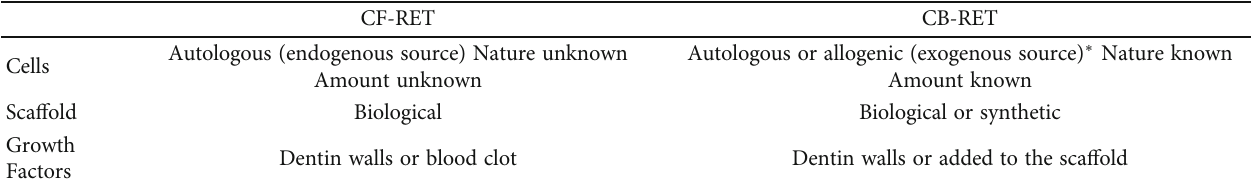
Table 1: Comparison between cell-free regenerative endodontic therapy (CF-RET) and cell-based regenerative endodontic therapy (CB- RET).